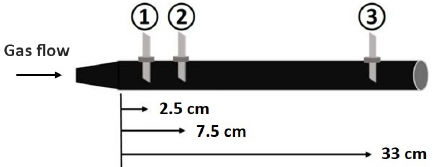
Figure 3. Scheme of the sensor tube used for modeling as well as for experiments with three different sensor mounting positions depending on the distance from the cone end. The inner diameter of the chamber is 2.54cm (1 (cid:48)(cid:48)